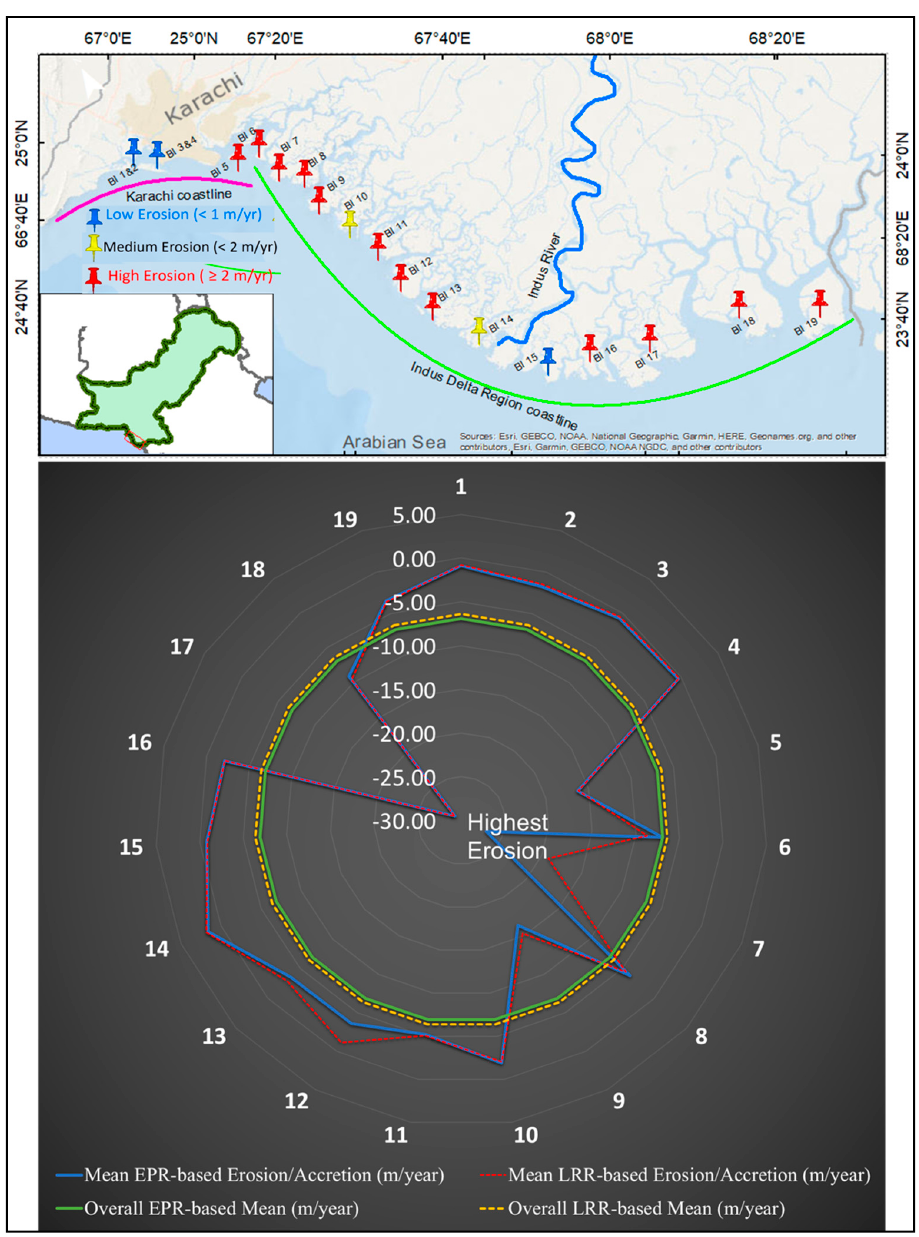
Figure 4. Statistical summary of the BI perimeter change rate during the period 1989–2018 (note: EPR = end point rate; LRR = linear regression rate). Different colors of pins in the upper panel represent three different classes of erosion ongoing in the BIs of the study area. Lower panel is a graphical representation of the average EPR and LRR rates in each BI zone.